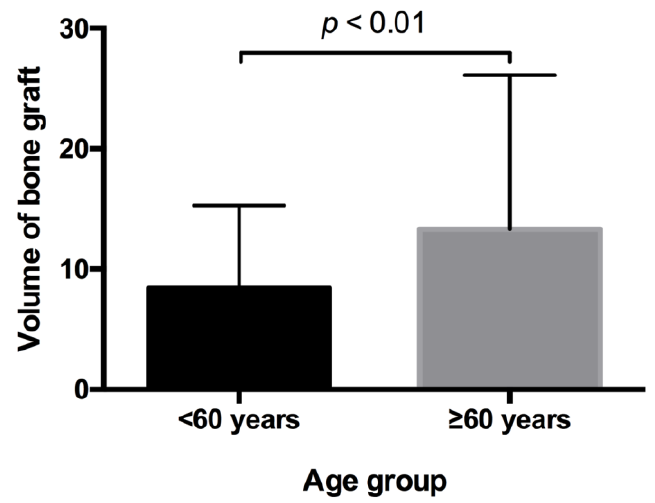
Figure 2. Comparison of groups for bone graft volume. The volume of the graft was documented in 315 out of 485 cases. In these, the mean bone graft was 8.39 cm 3 (SD ± 6.91; Median 6 cm 3 ) in younger patients and 13.32 cm 3 (SD ± 12.787; Median 10 cm 3 ) in elderly patients. p -value corresponding to testing for differences between groups with Mann – Whitney test ( p < 0.01).